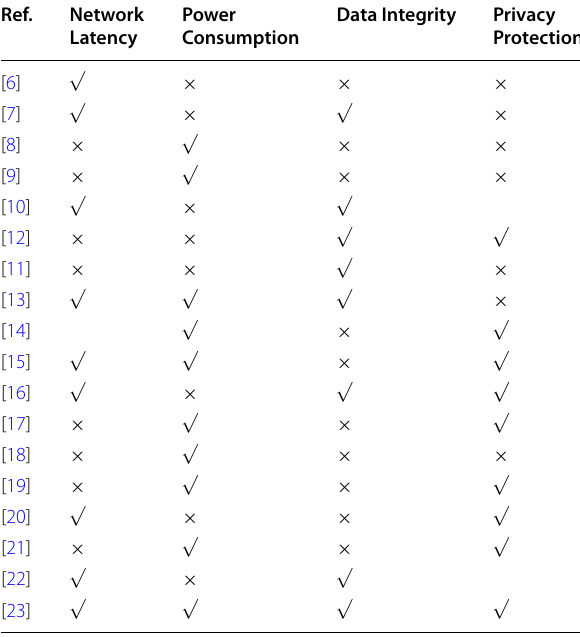
Table 1 Comparison of data aggregation